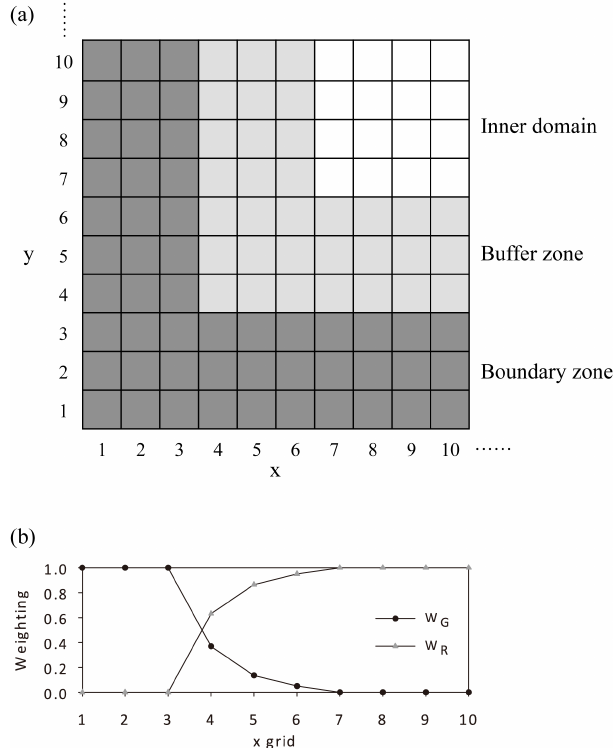
Figure 2. (a) The structure of the lower-left corner in the re- gional domain for boundary treatment. (b) Weighting function of the global base field (black) and regional model field (gray) along the x axis, which includes the inner domain. This example assumes that the grid size of the boundary and buffer zones is